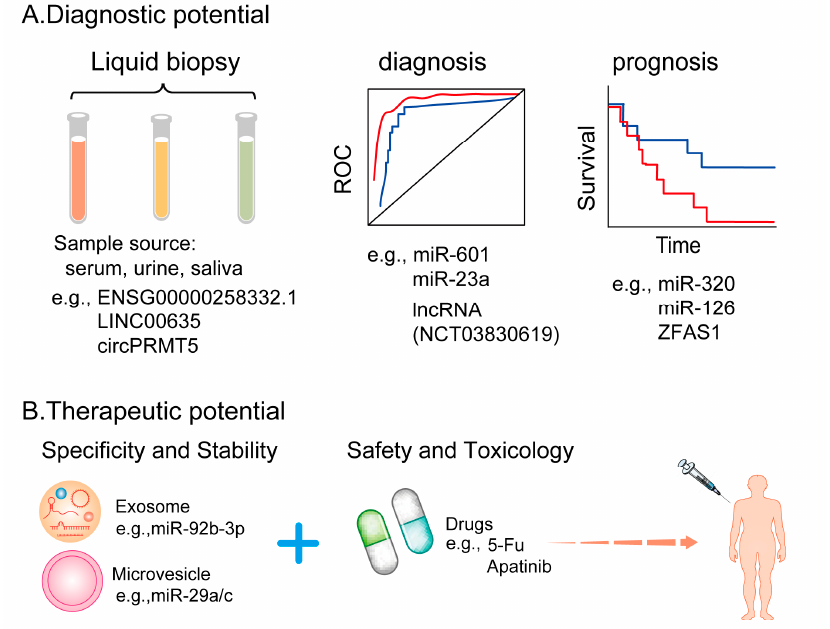
Figure 3. The potential clinical application of EV-derived ncRNAs in tumor angiogenesis ( A ) EV-derived ncRNAs can be detected from patient samples and are potential diagnostic and prognostic biomarkers. ( B ) A combination of targeting EV-derived ncRNAs and using conventional anti-angiogenic agents can enhance therapeutic efficacy.